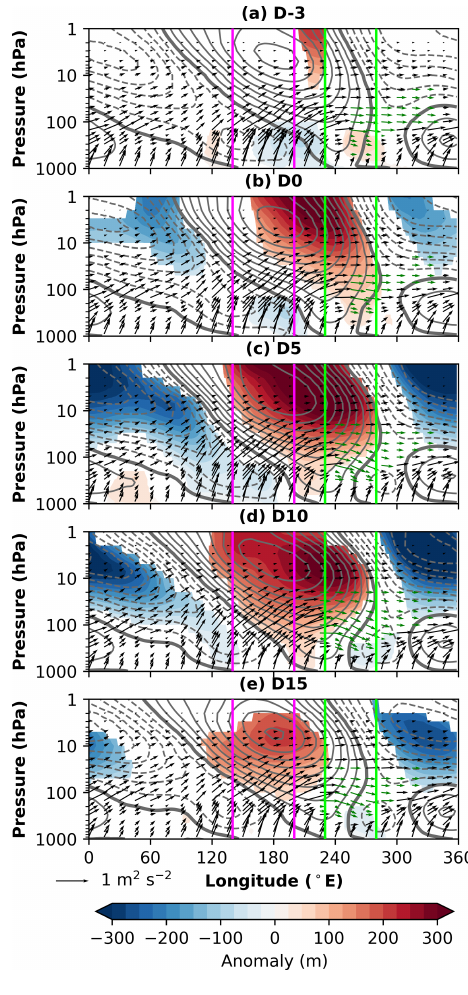
Figure 12. Evolution of the mean vertical wave structure associated with reflection events. Grey contours denote the average 40–80 ◦ N eddy geopotential height field (contours every 100m, dashed negative, zero contour thickened). Shading denotes significant departures of the eddy height field from climatology, with significance assessed as described in Sect. 2. Vertical pink lines delineate the longitudinal range of the Siberian box (140–200 ◦ E), and vertical green lines delineate the longitudinal range of the Canadian box (230–280 ◦ E). Arrows denote the vertical and zonal components of the 40–80 ◦ N average Plumb wave activity flux, calculated over wavenumbers 1–3 (Plumb, 1985). Green arrows indicate the vertical component is downward. Arrows are scaled following Millin et al.